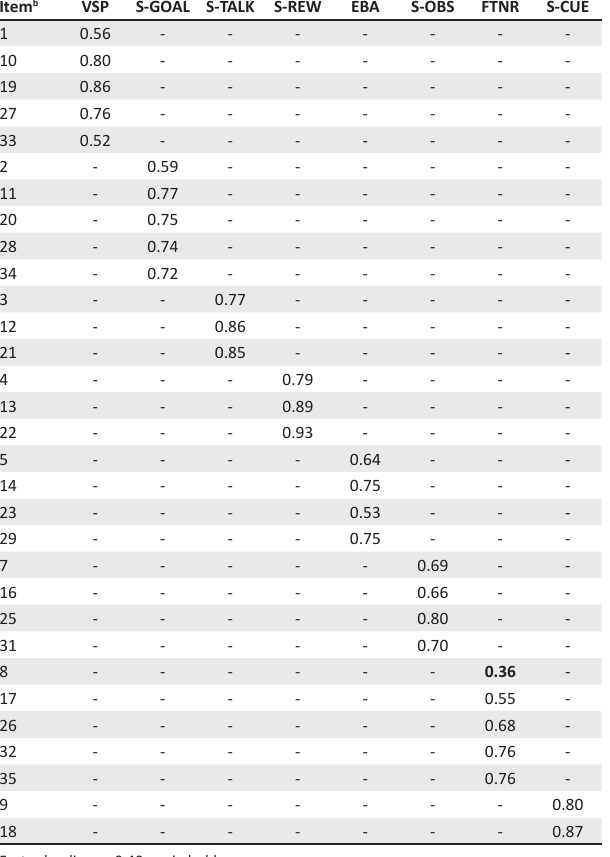
TABLE 5: Factor loading estimates a for self-leadership measurement model (first-order).